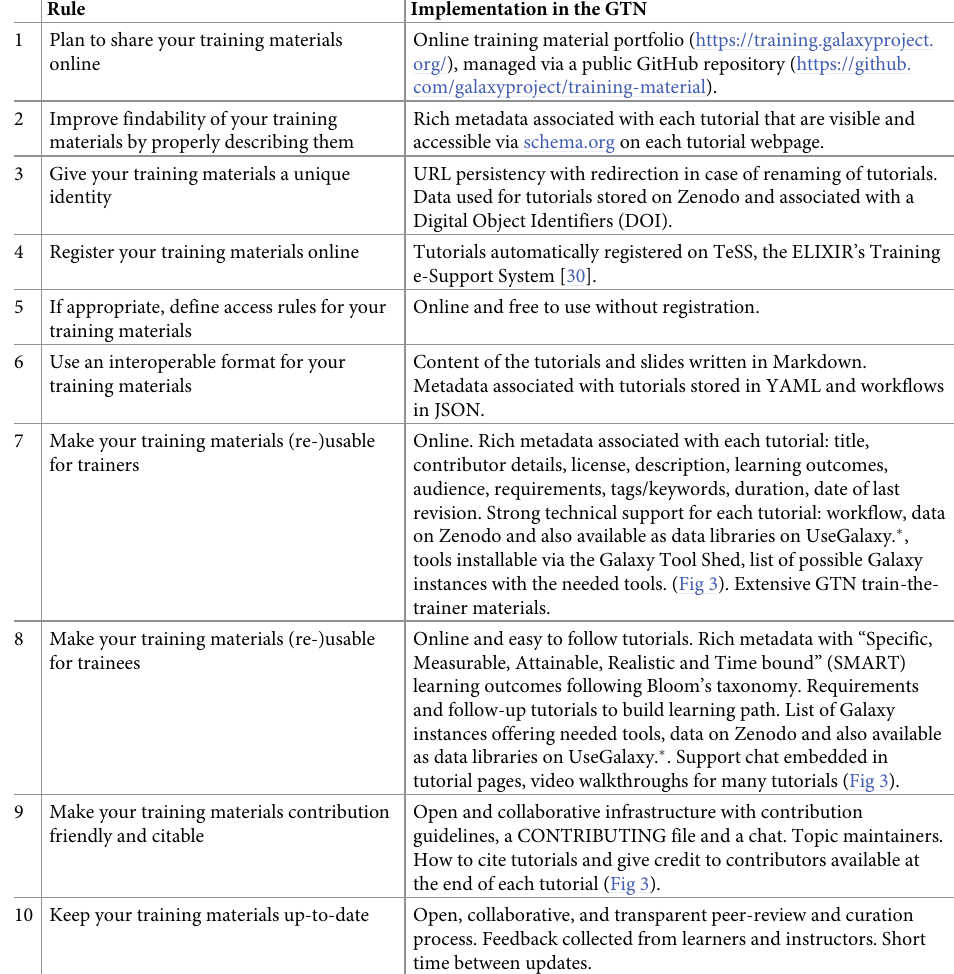
Table 1. Implementation of the “Ten simple rules for making training materials FAIR” [16] in the